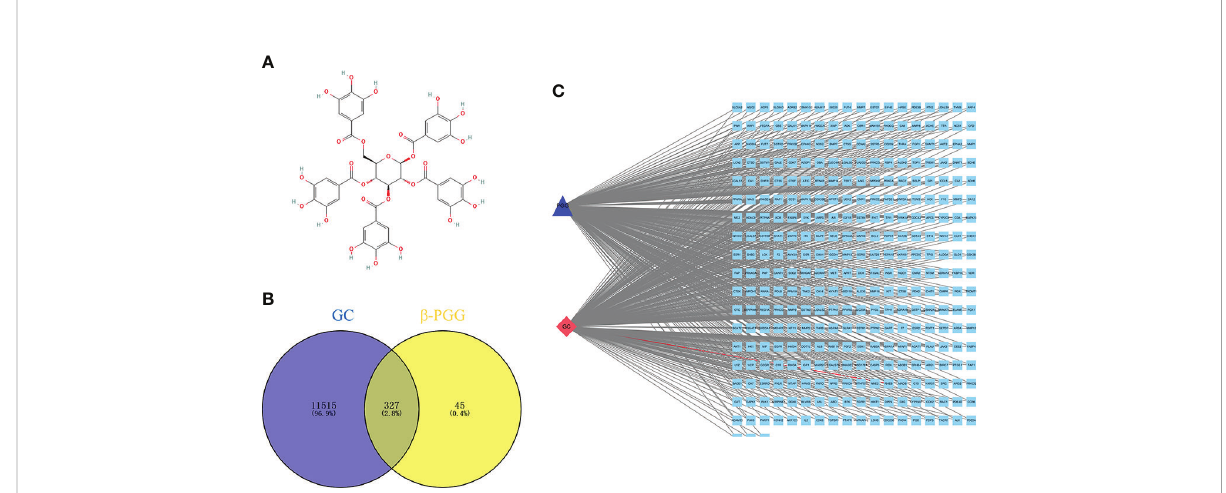
FIGURE 1 Pharmacological networks of 1,2,3,4,6-pentagalloyl- b -D-glucose ( b -PGG) and gastric cancer. (A) The 2D structure of b -PGG. (B) Venn diagram showing the drug – disease interactions. (C) The “ GC – target – PGG ” network.